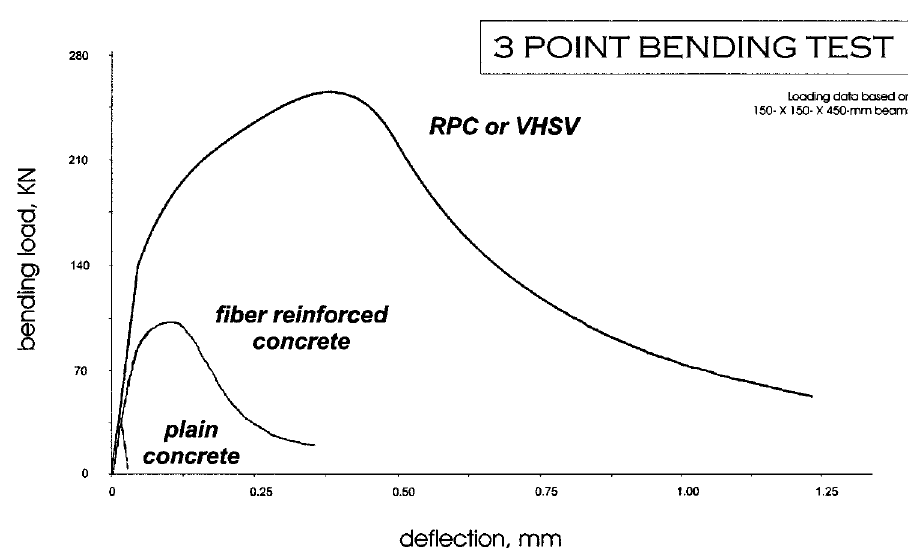
Fig. 1. Comparative flexural-toughness curves of VHSC concretes with plain and fiber-reinforced concrete.